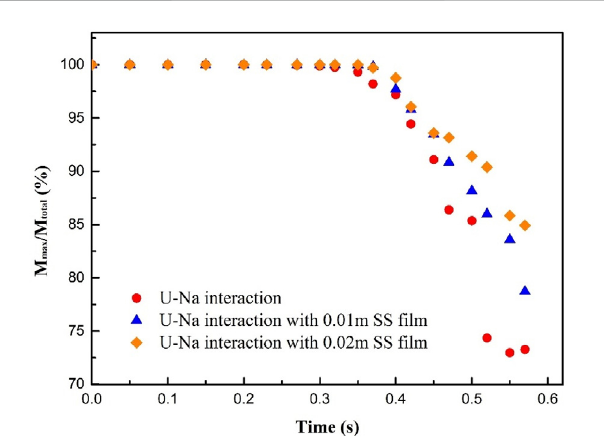
FIGURE 15 Thevariationofthemassfractionofthemainuraniumbodyrelative to the total mass.